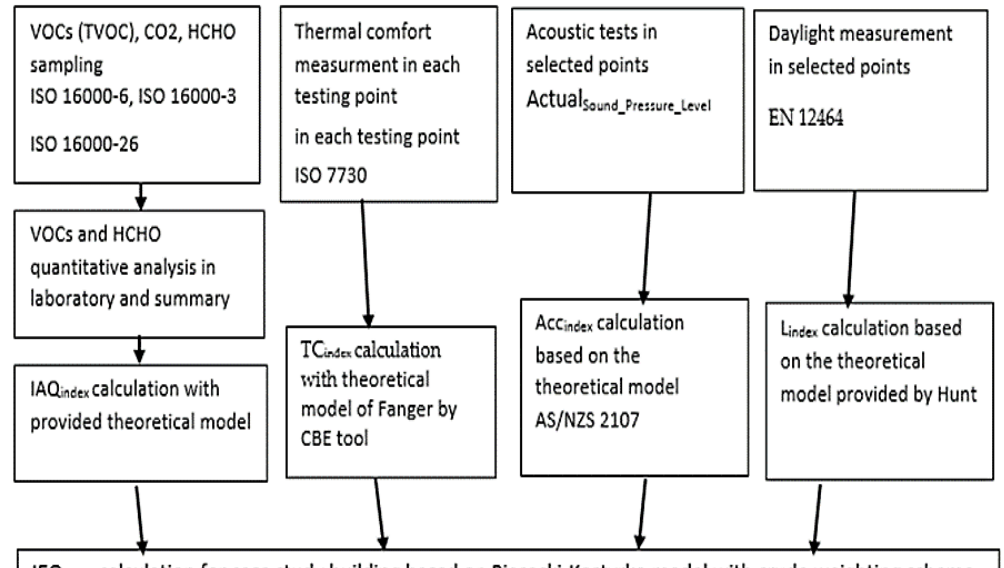
Figure 6. The research steps necessary to determine the IEQ index for buildings, including physical and design parameters of buildings and subcomponent models.